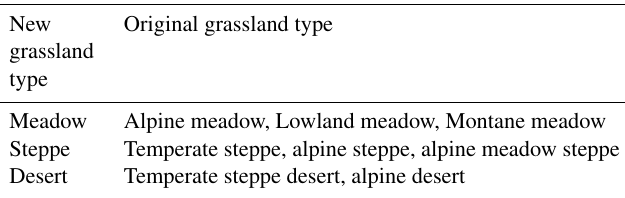
Table A1. Combined grassland